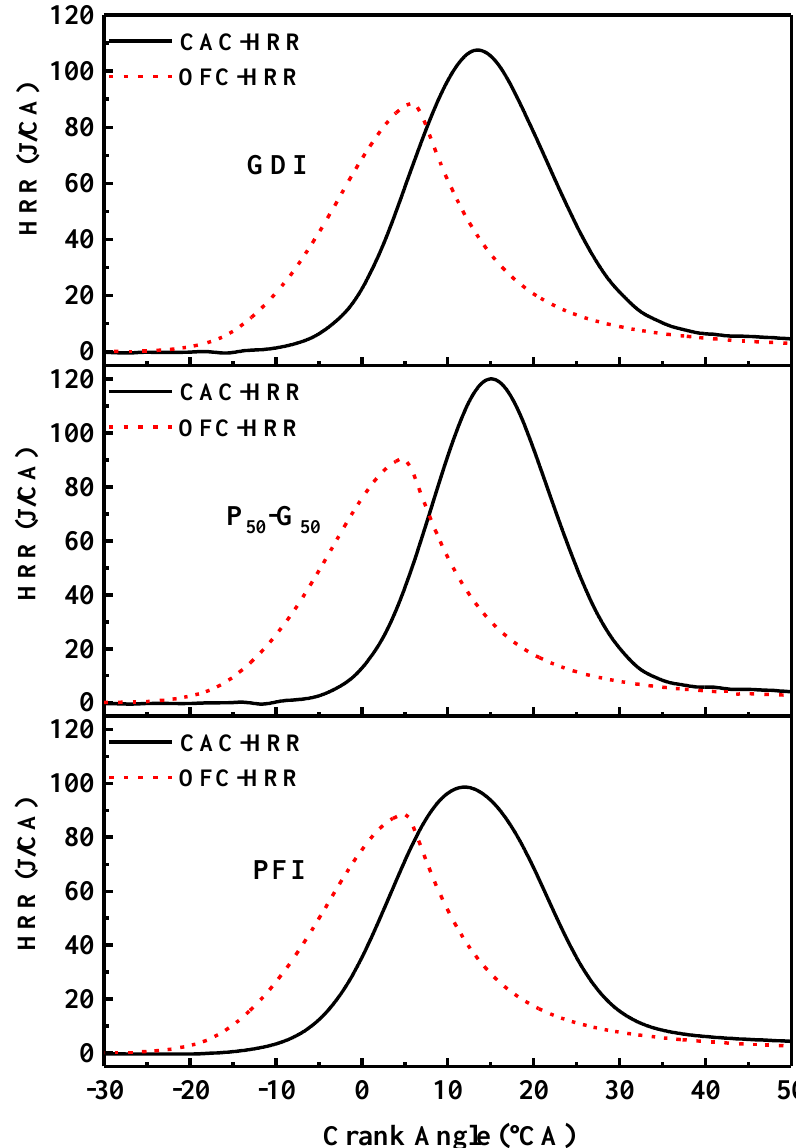
Figure 7. Comparison of HRR between CAC and OFC.